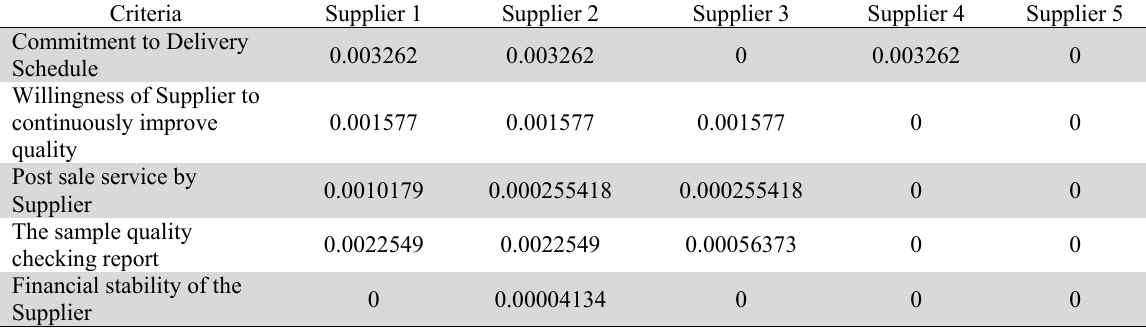
The sample quality